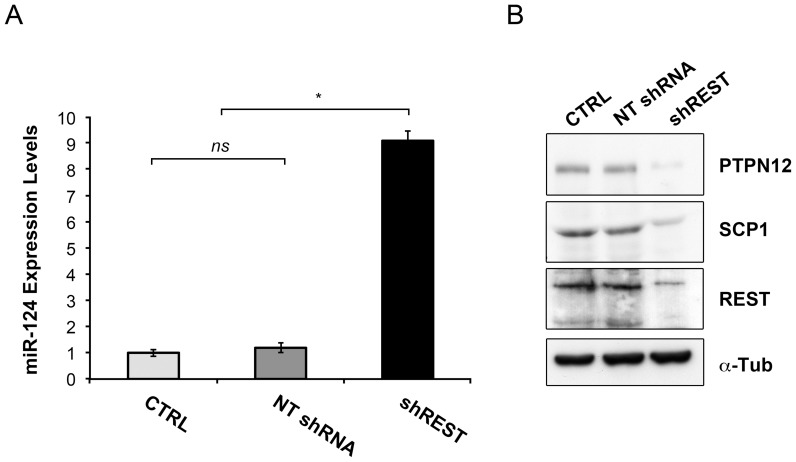
REST controls SCP1 and PTPN12 phosphatases expression levels in human tumorigenic-competent GBM cells by modulating miR-124 levels.(A) Quantitative RT-PCR analysis shows elevated miR-124 expression following REST knockdown in GB7 cells (shREST; 4 days post infection) compared to CTRL and NT shRNA control cultures. miR-124 expression level was normalized to RNU48 levels. Results are relative to three independent experiments. Data are means ± s.d. (B) Expression levels of miR-124 targets, SCP1 and PTPN12 phosphatases, in GB cells are controlled by REST. Downregulation of REST induces a reduction of the protein levels of SCP1 and PTPN12 in GB7 cells. Cultures were transduced with with non targeting (NT shRNA) and REST (shREST) shRNA, cultured for 4 days and analysed for expression of SCP1 and PTPN12 by western blot assay. CTRL sample represents the non trasfected culture. Alpha Tubulin levels were used as loading control. Data are means ± s.d. ns not significant, *P<0.001.